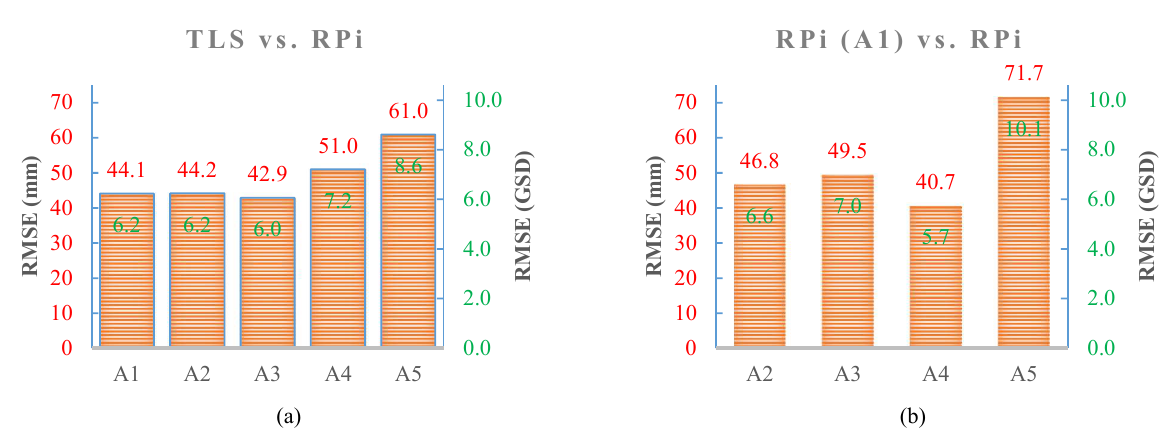
Figure 7. Summary of the RMSE of the distances between (a) the reference TLS point cloud and the RPi models and (b) the first RPi model (A1) and the consecutive four RPi models (A2 to A5).